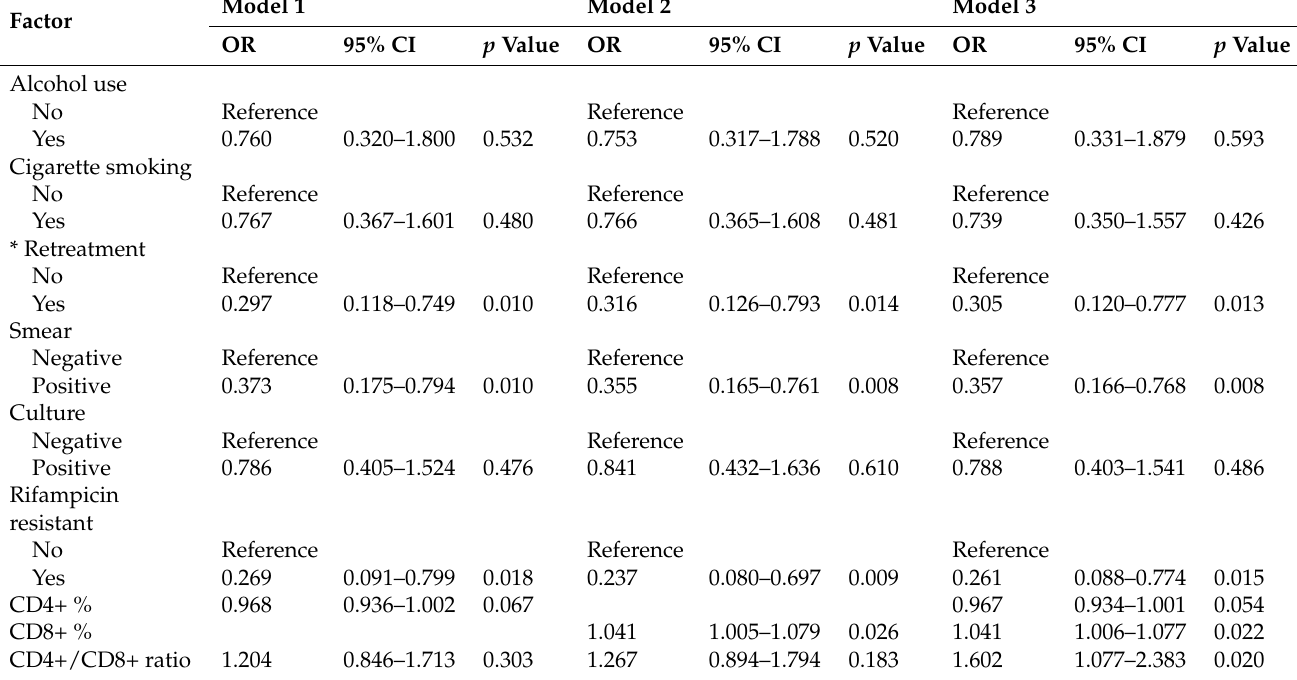
Table 3. Multiple logistic regression analysis of the factors associated with